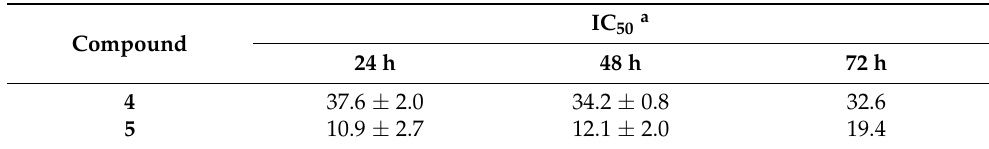
Table 2. Cytotoxicity (IC 50 in µ M) on Vero cells of perylene bisimide derivatives after 24, 48 and 72 h of incubation.